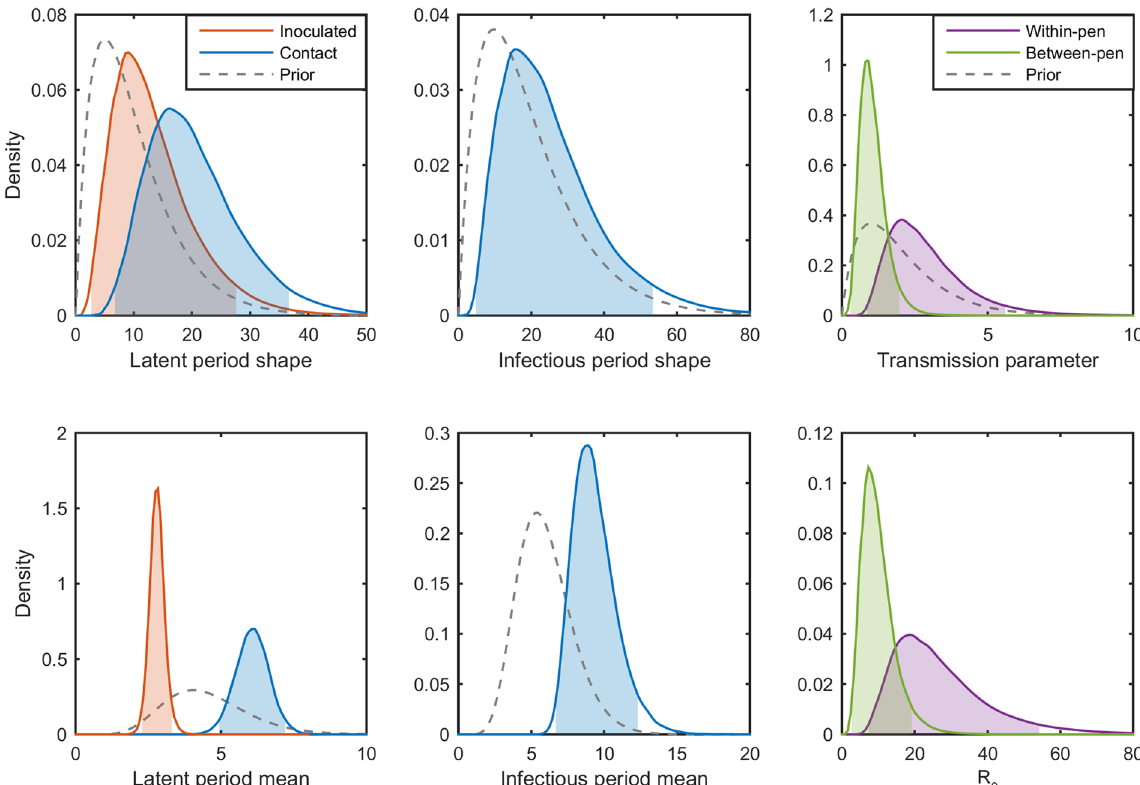
Figure 6. Epidemiological parameters for African swine fever virus (ASFV) in pigs. Marginal posterior distributions for each parameter inferred from the ASFV transmission experiments. The latent period shape and mean posteriors are plotted in blue for in-contact lambs and in orange for inoculated. The transmission parameter and R 0 posteriors are plotted in purple for within-pen transmission and in green for between-pen transmission. The shaded areas indicate the 95% highest posterior density intervals and priors are plotted as grey dashed